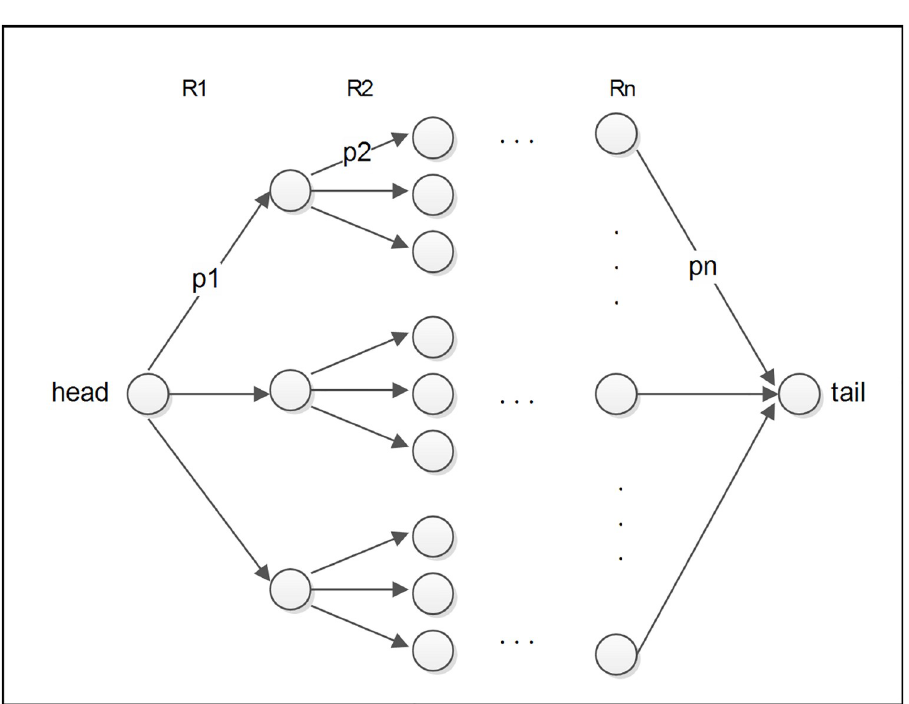
Fig 5. Path prediction for a specific head and